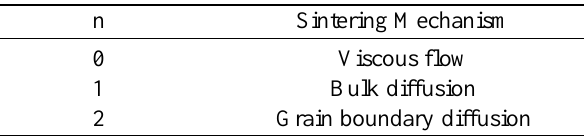
Table 1. Sintering mechanism according to Wooffrey and Bannis- ter 7,8